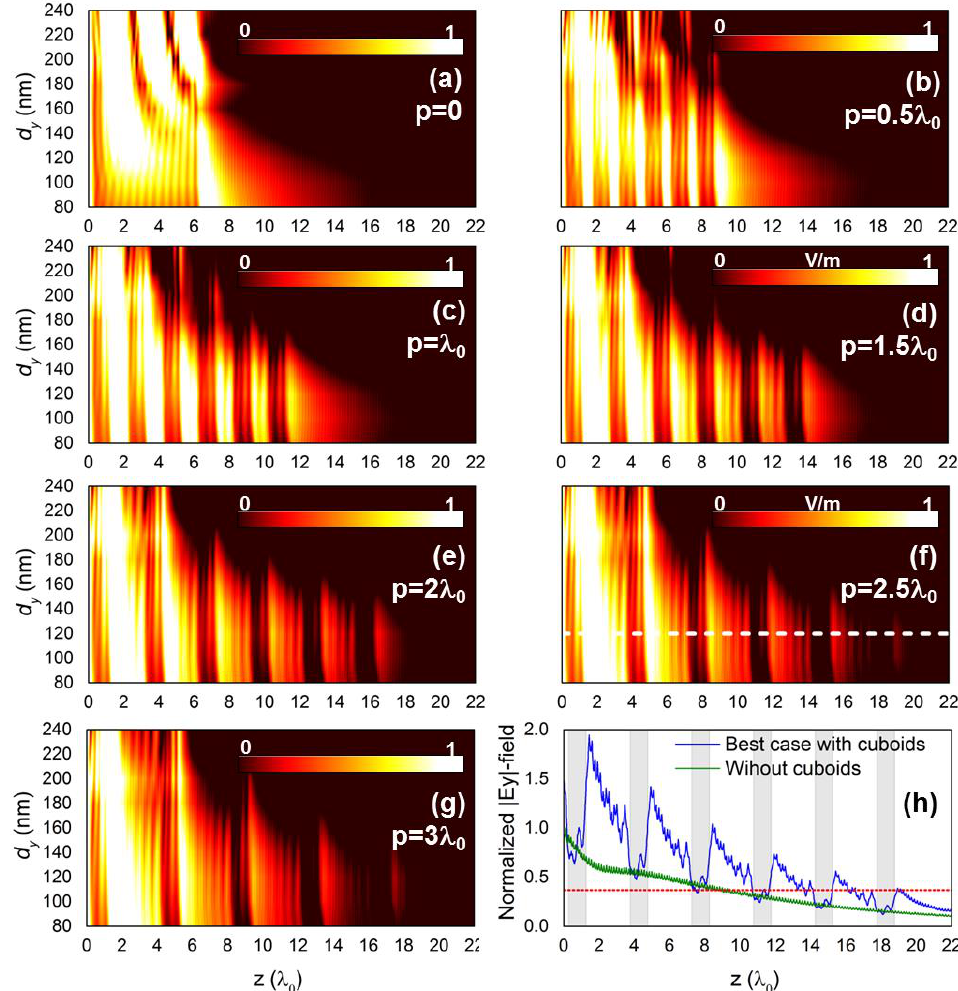
Figure 3. Normalized magnitude of the E y field as a function of the propagation z- axis and height d y of the cuboids when the distance between cuboids is: ( a ) p = 0; ( b ) p = 0.5 λ 0 ; ( c ) p = λ 0 ; ( d ) p = 1.5 λ 0 ; ( e ) p = 2 λ 0 ; ( f ) p = 2.5 λ 0 and ( g ) p = 3 λ 0 . ( h ) Numerical results of the normalized magnitude of the electric field along the propagation axis at the surface of the metal for the optimal case, p = 2.5 λ 0 and d y = 120 nm (extracted from the dashed line shown in panel ( f )) (blue curve) and a flat metal film (green curve). The red curve corresponds to a decay of 1/e with respect to the amplitude of the incident surface plasmon polaritons (SPP) at the input. The 3D cuboids are also shown as grey blocks.